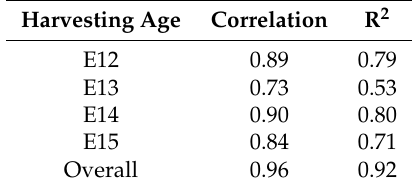
Table 4. Pearson’s correlation values for Crown-Rump Length and Developmental